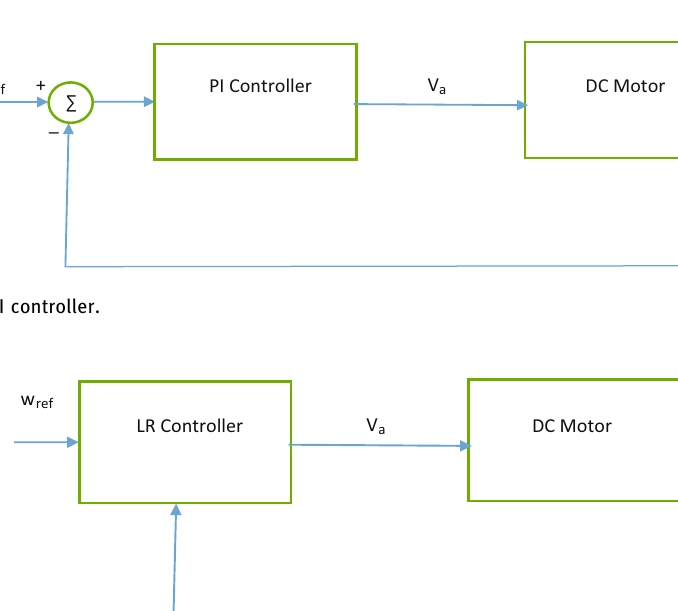
Figure 3: Diagram of LR